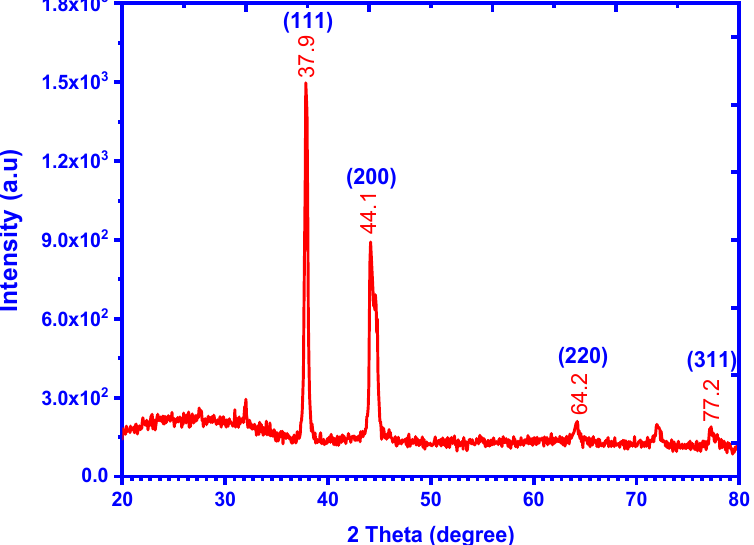
Figure 6. The as-biofabricated Ag NPs X-ray diffractogram from the GB leaf extracts.